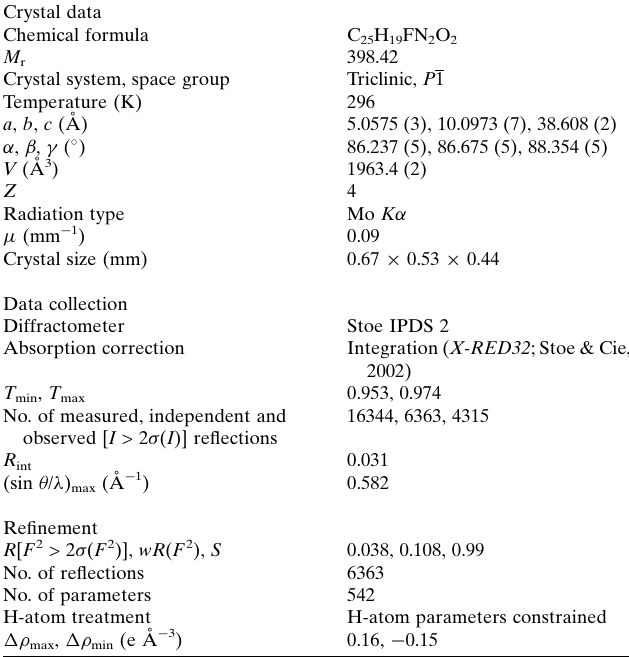
Table 2 Experimental details. Crystal data Chemical